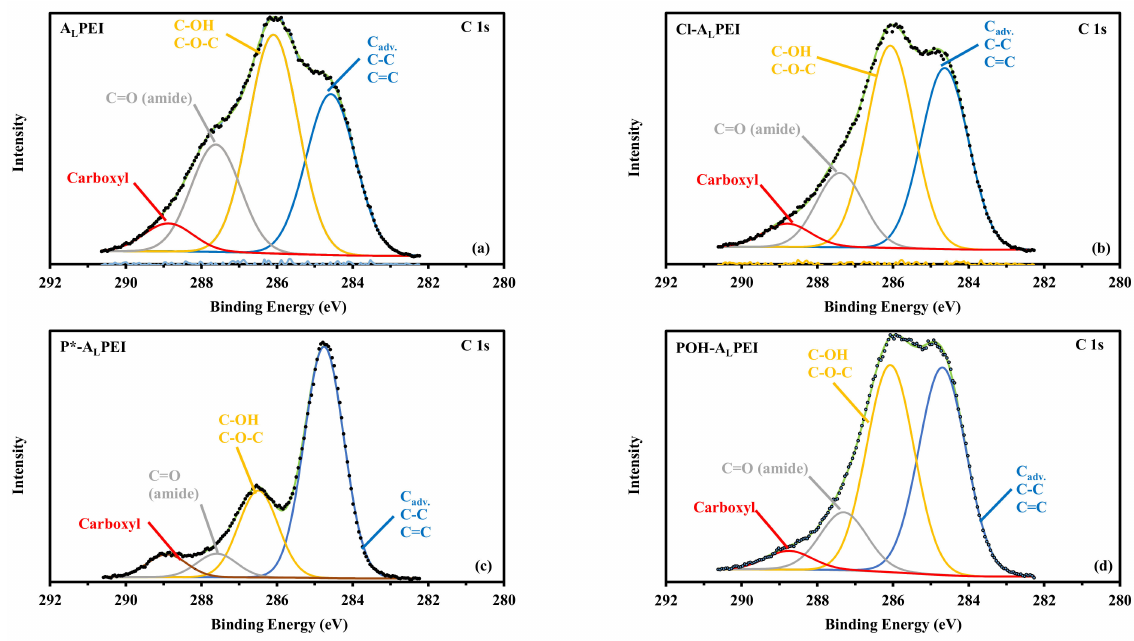
Figure 4. HRES XPS C 1 s core level spectra for A L PEI ( a ), Cl-A L PEI ( b ), P*-A L PEI ( c ) and POH-A L PEI ( d